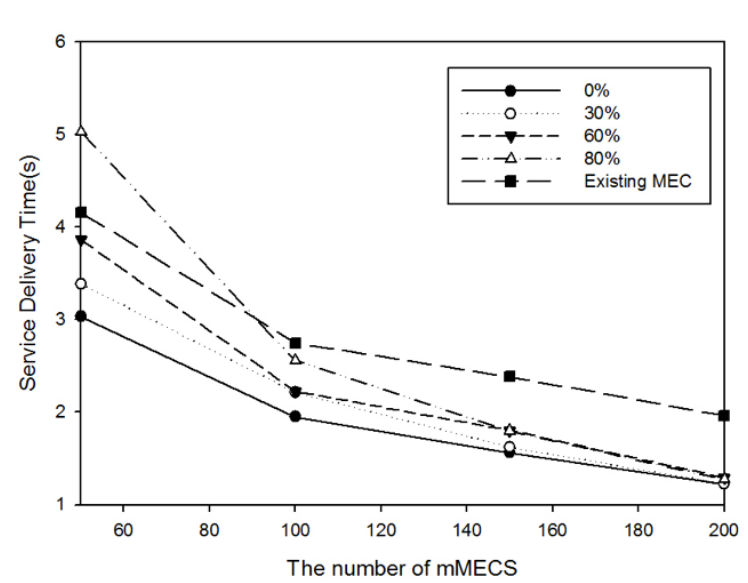
Figure 13. Service delivery time for the mobility preference: Level